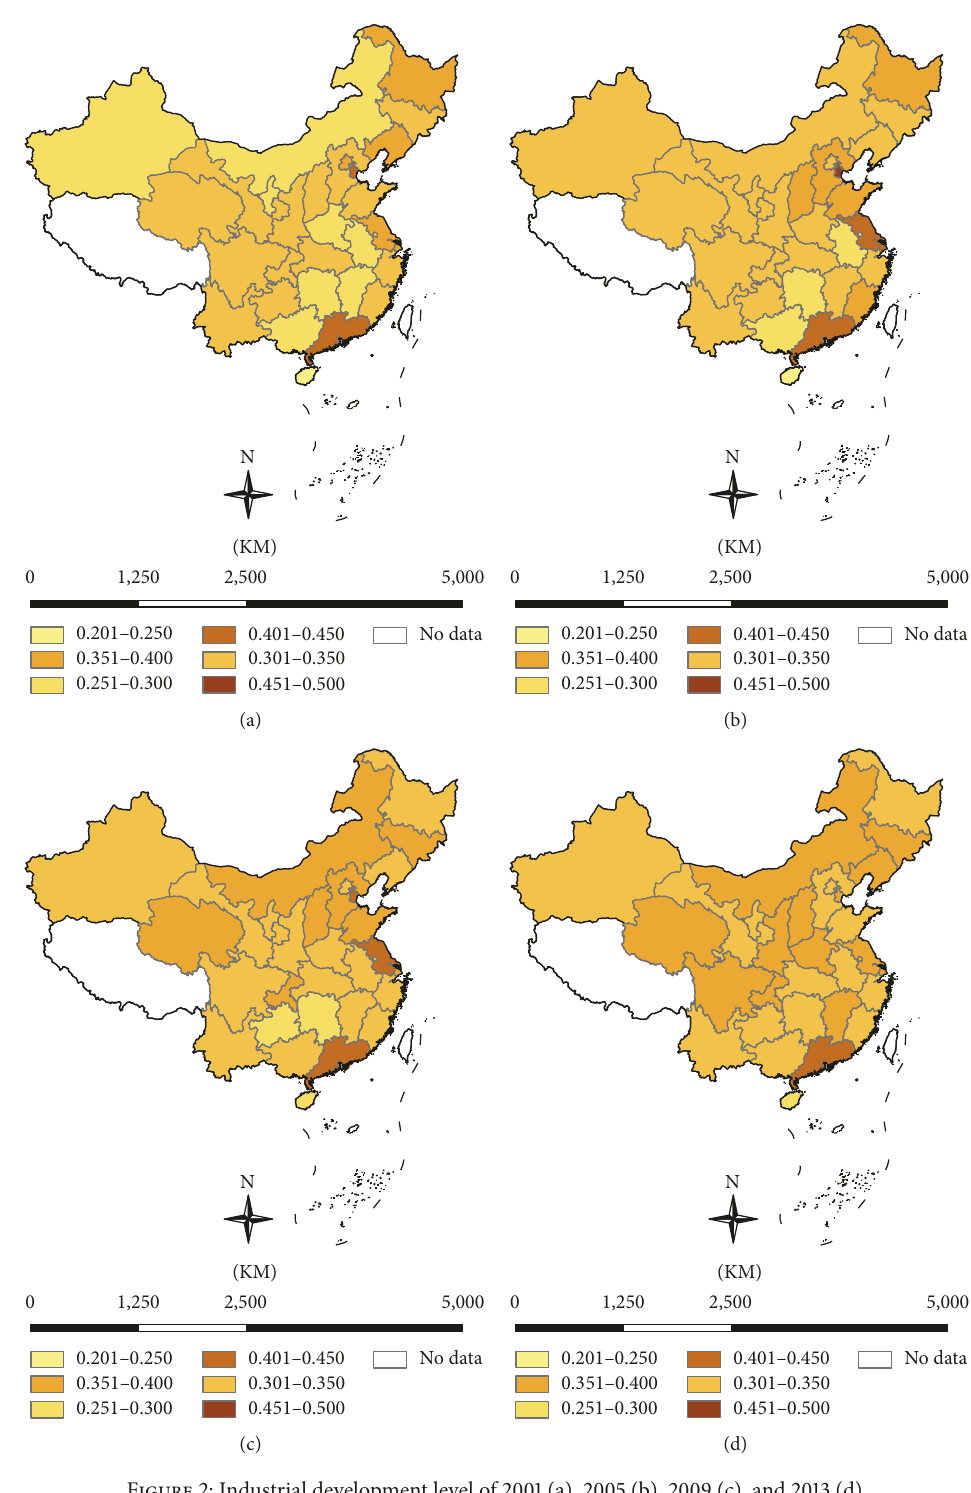
Figure 2: Industrial development level of 2001 (a), 2005 (b), 2009 (c), and 2013 (d).